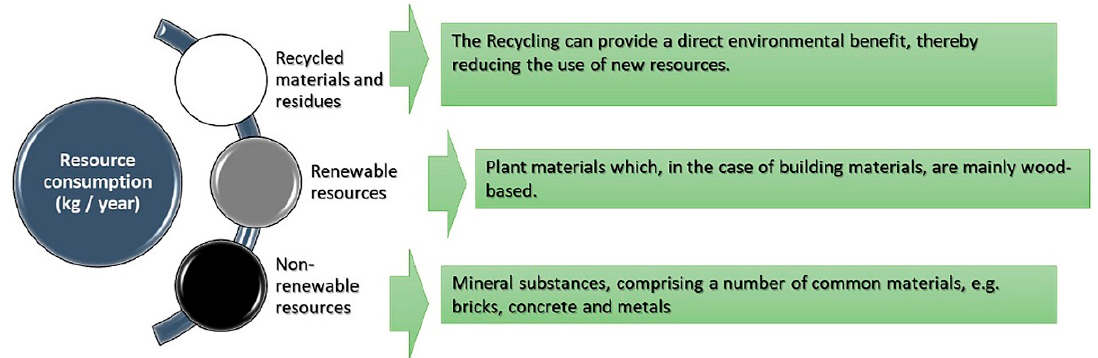
Figure 3. The environmental profile (EP) shows the environmental impact of Resource consumption. The environmental consequences of resource use may include a lack of energy, in- creased area consumed, and risks associated with the extraction or cultivation process. The results of applying this indicator to the five chosen wooden façade materials are seen in the diagram below (see Figure 4).